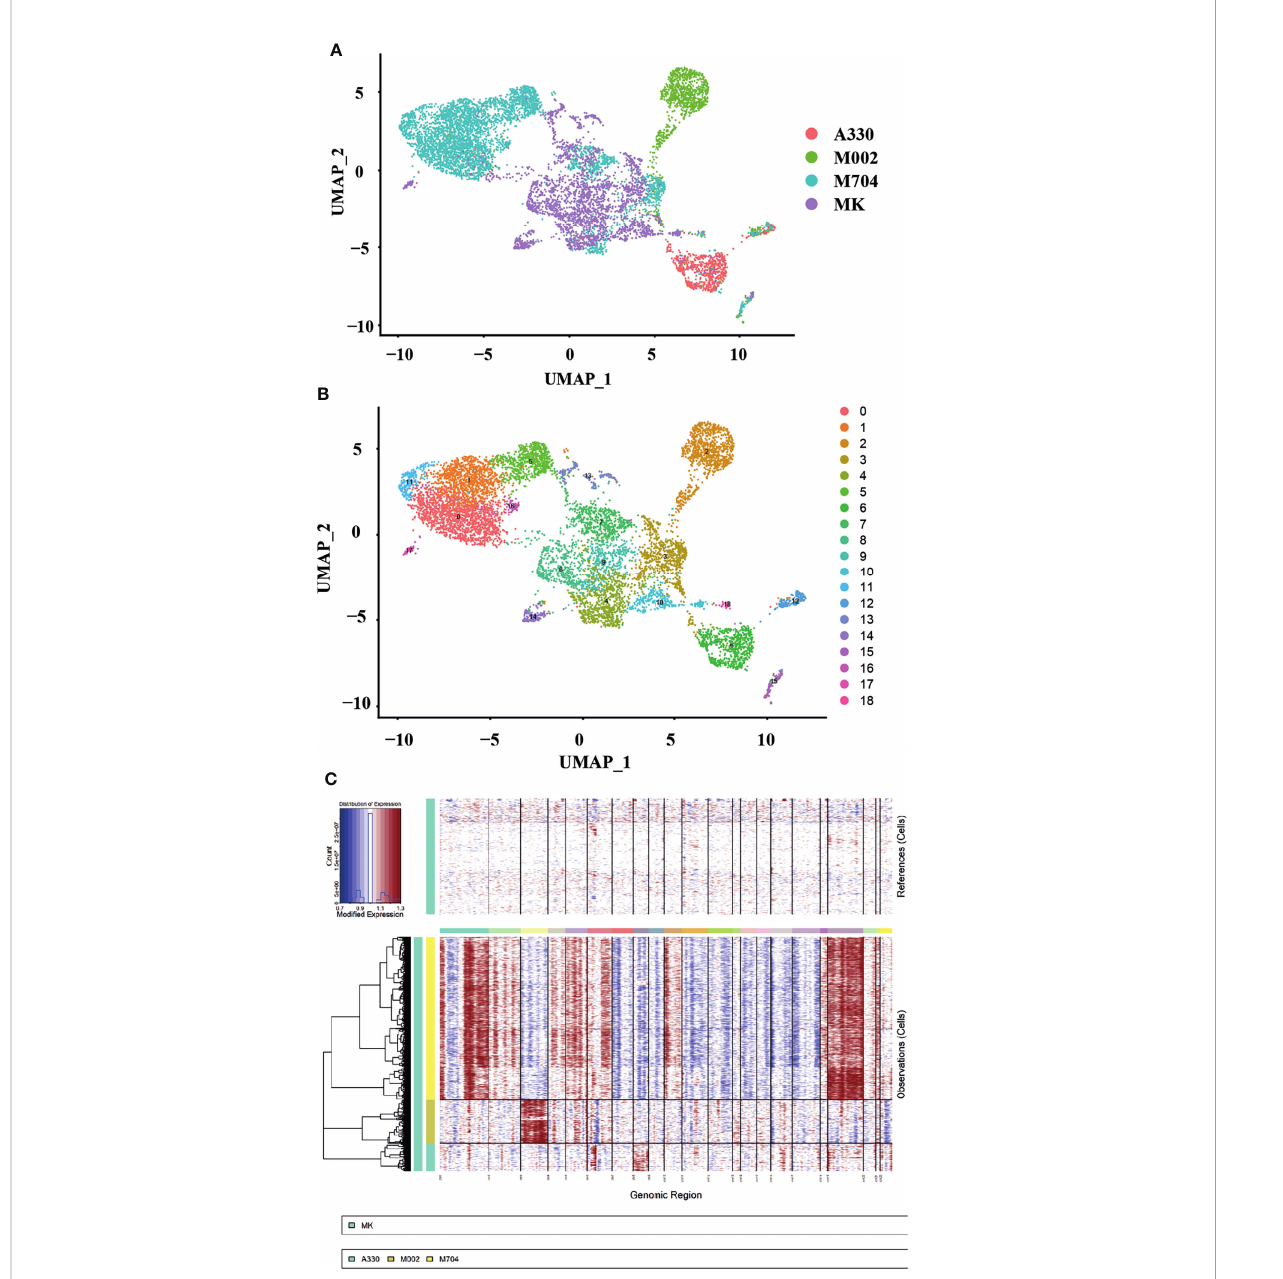
FIGURE 3 The single-cell landscape and copy number variance (CNV) speculation of the tumors and normal MK cells of the fetal liver (FL). (A, B) UMAP plots showing the single-cell landscape of tumor cells in AMKL and normal MK cells in FL (the control). (C) The plot shows the CNV levels of AMKL tumor and the normal control. The upper column represents the CNVs of normal FL MK cells. The x-axis exhibits chr1 to chr22. The y- axis exhibits the cell clusters. The red color represents the gain of copies, and blue represents loss of